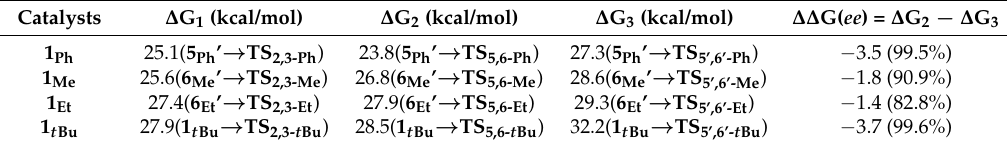
Figure 6. Free energy profile for the asymmetric transfer hydrogenation catalyzed by 1 t Bu . Table 1. Energy barriers of 1 Ph , 1 Me , 1 Et , and 1 t Bu .